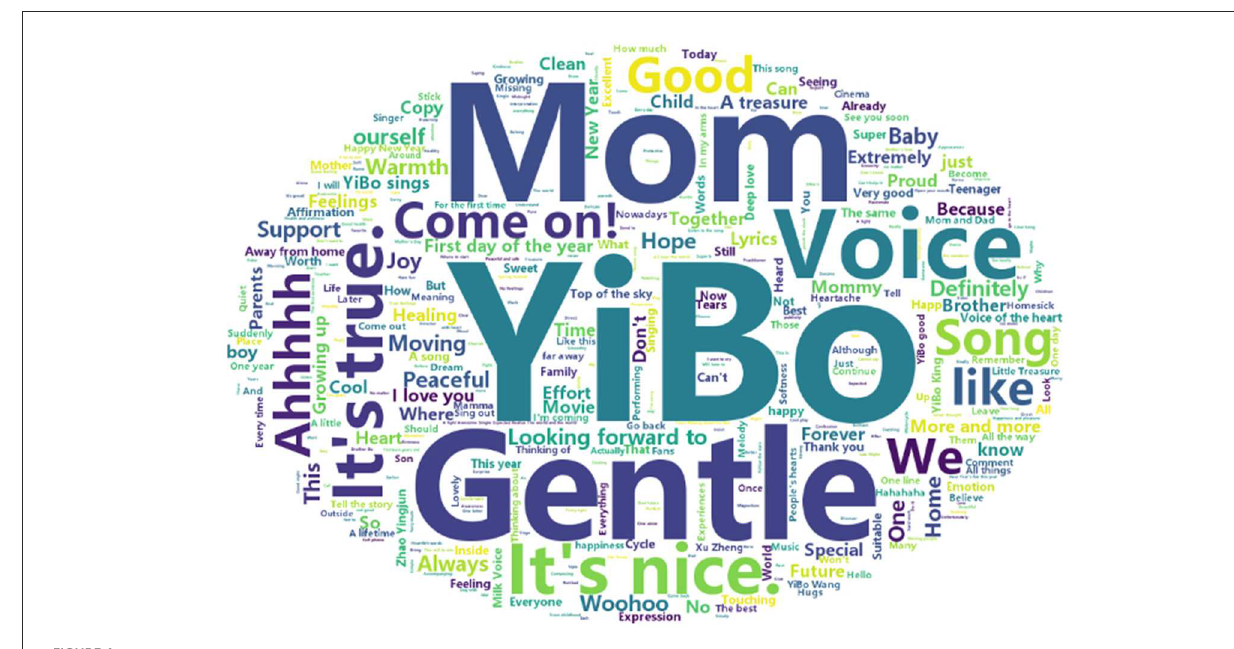
FIGURE4 Word-cloud